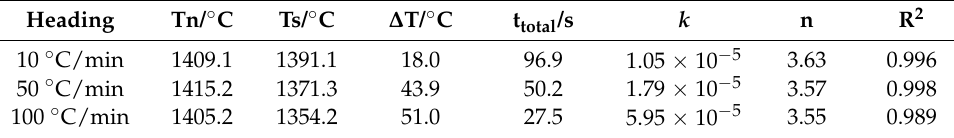
Figure 1. Solidification process of Ce-HMASS sample observed in situ via HT-LSCM. ( a ) cooled at 10 °C /min, ( b ) cooled at 50 °C /min, ( c ) cooled at 100 °C /min, and ( d ) fitted curves of the solid volume fraction as a function of time. Table 2. Analysis results of Ce ‐ HMASS sample solidification process.